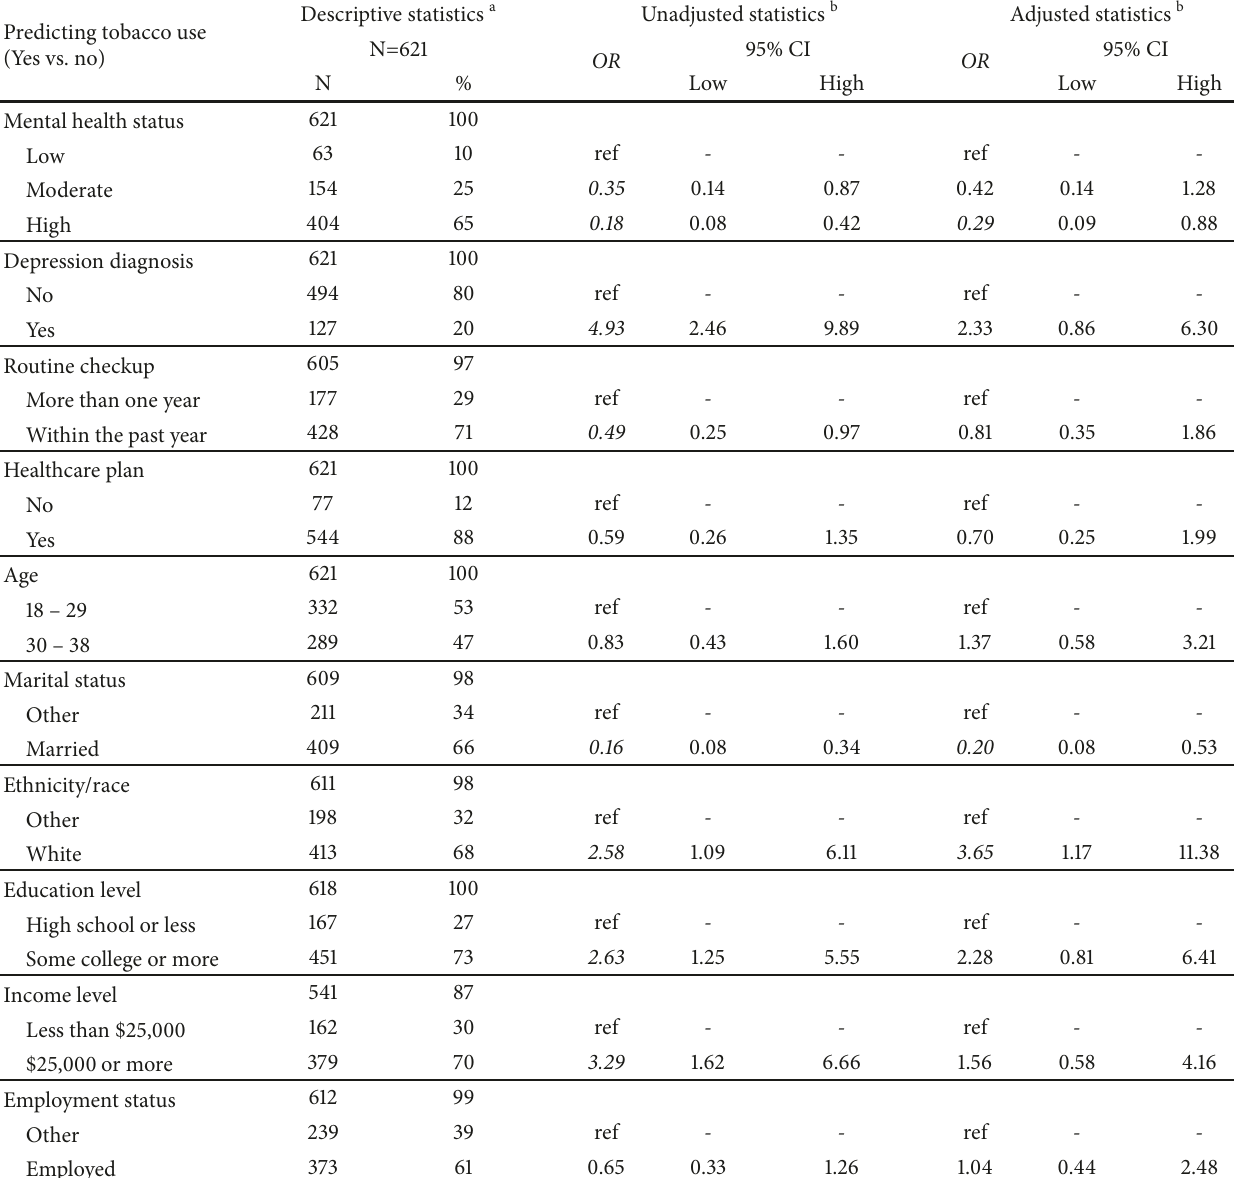
Table 1: Participant characteristics, unadjusted results, and adjusted